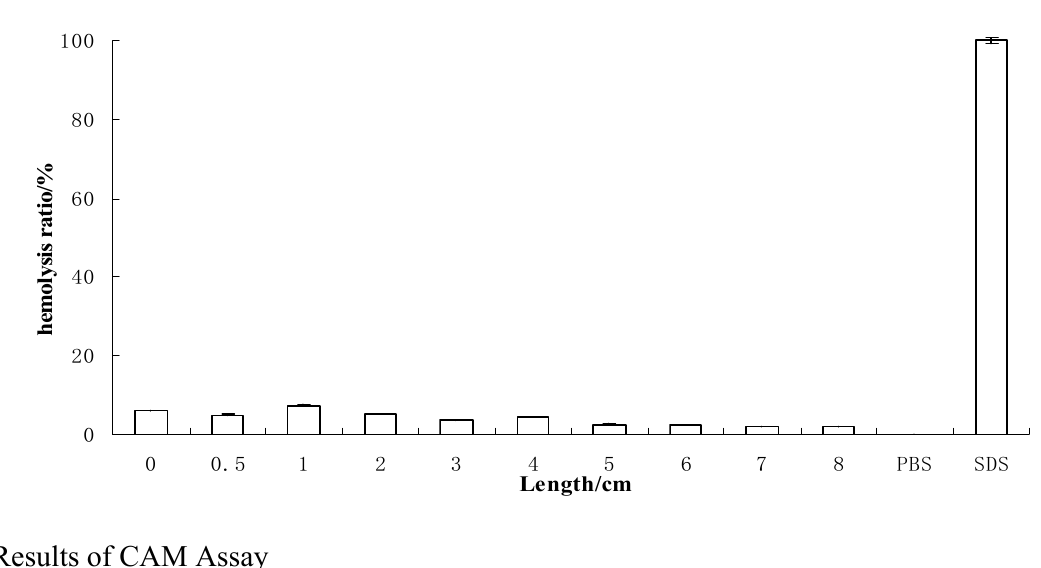
Figure 5. RBC test results for extracts (40 mg/mL) obtained from different lengths of bean sprouts (n = 3).